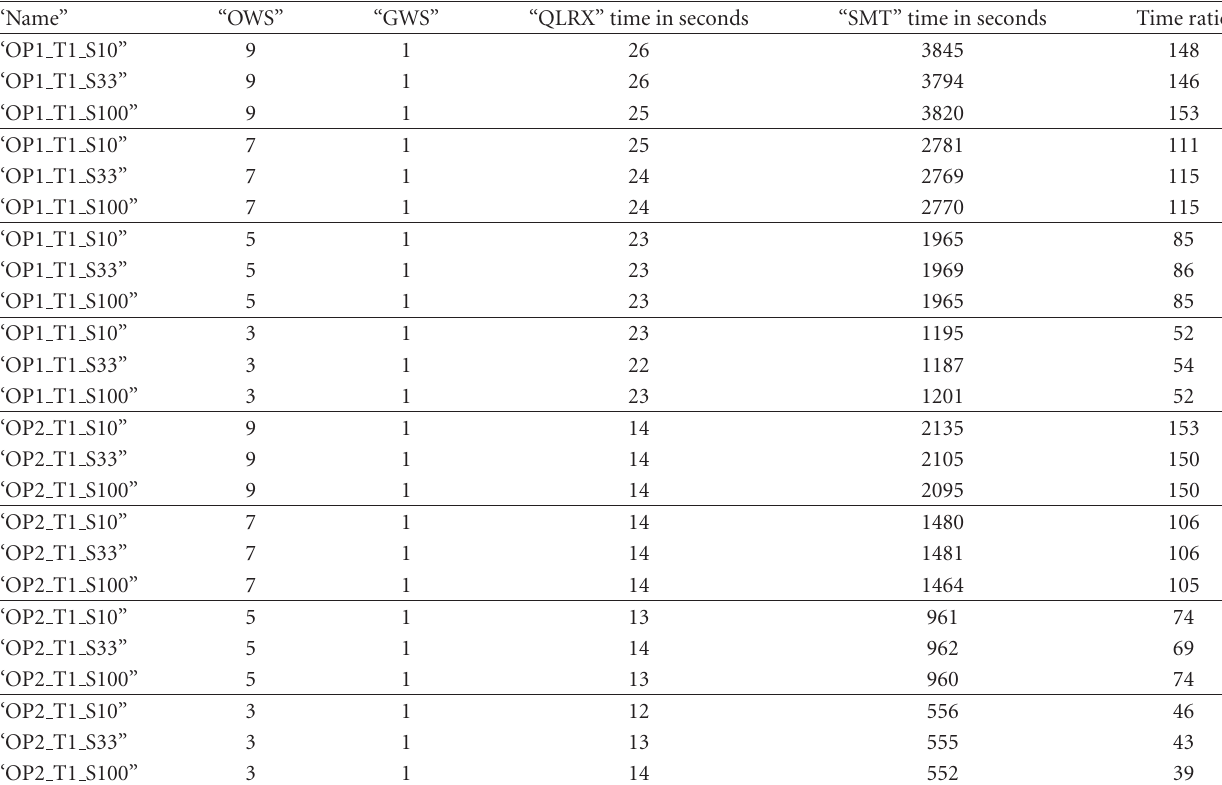
Table 2: This table shows the time it took to complete the calculation of a dataset.